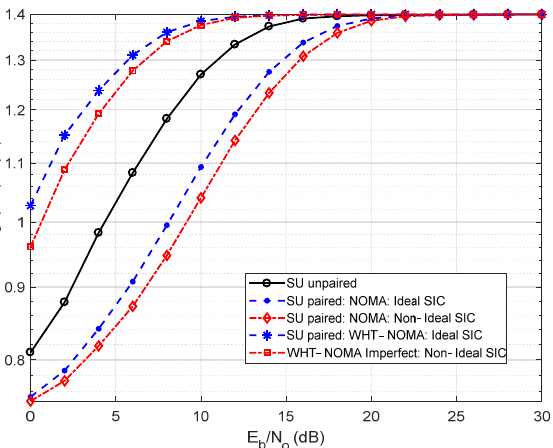
Figure 10. Throughput performance using BPSK modulation; NOMA vs. WHT–NOMA, power